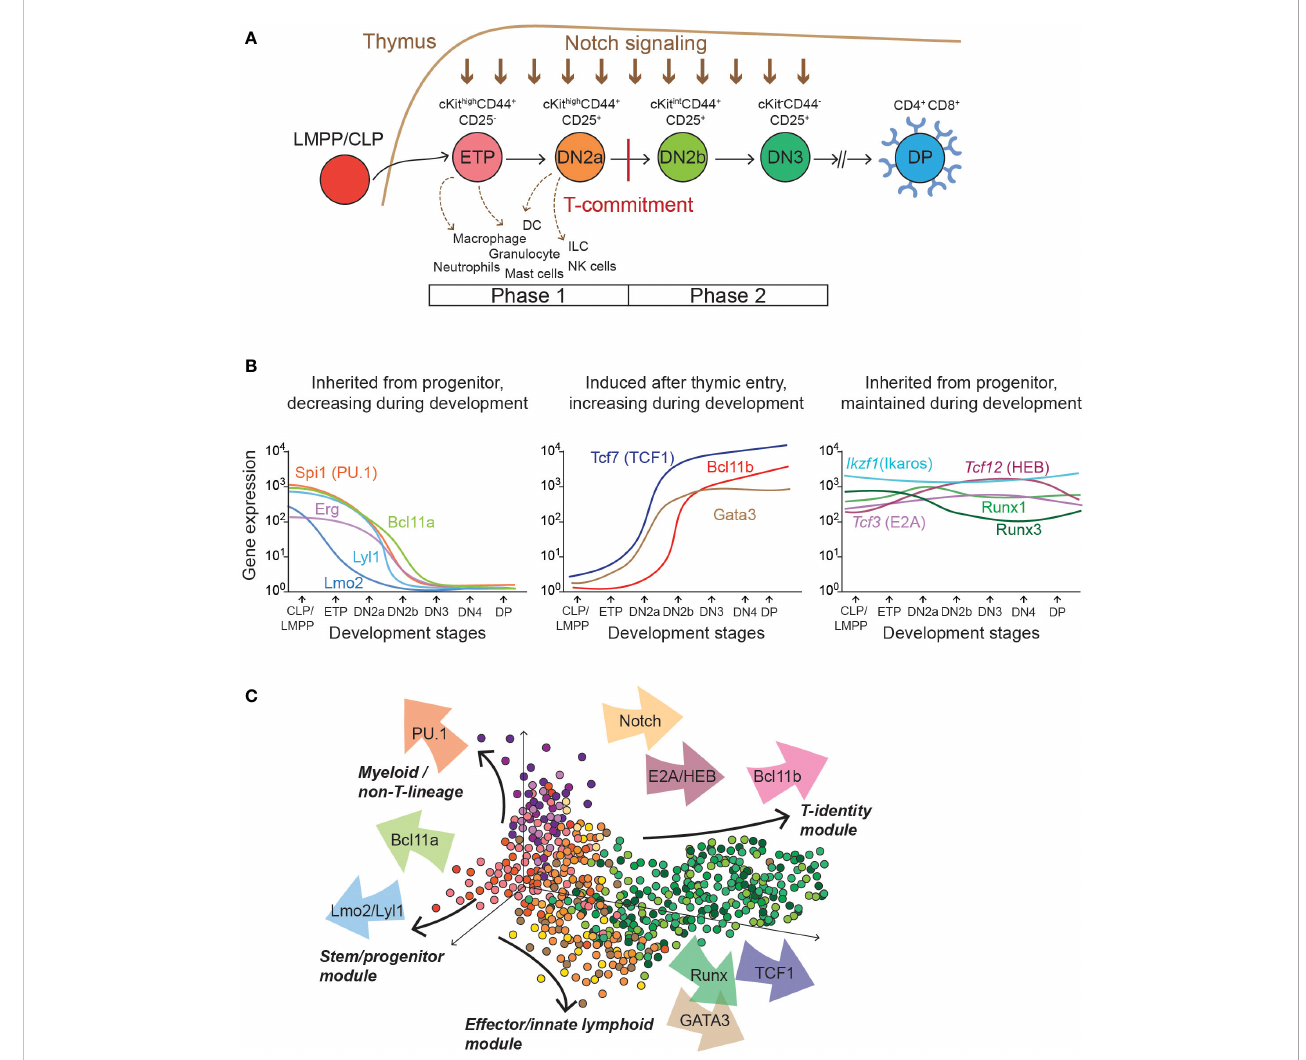
FIGURE 1 T cell development stages and transcription factor expression kinetics. (A) Diagram depicts different stages of early thymic T cell development that T- progenitor cells sequentially go through. Informative surface proteins that are utilized to de fi ne each stage are indicated (cKit, CD44, CD25 for ETP to DN3; CD4 and CD8 for DP). Developmental plasticity to generate alternative, non-T-lineage cells is shown with dotted arrows. Note that these alternative lineage potentials are silenced after T-lineage commitment. Lineage commitment to a T cell fate distinguishes Phase 1 (before T-lineage commitment) and Phase 2 (after T-lineage commitment). CLP, Common lymphoid progenitor, LMPP, lympho-myeloid primed progenitor. (B) Graphs show mRNA expression kinetics of important transcription factors involved in early T cell gene regulation programs. Left: Transcription factors